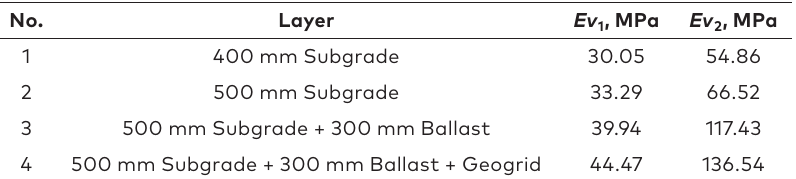
from numerical studies